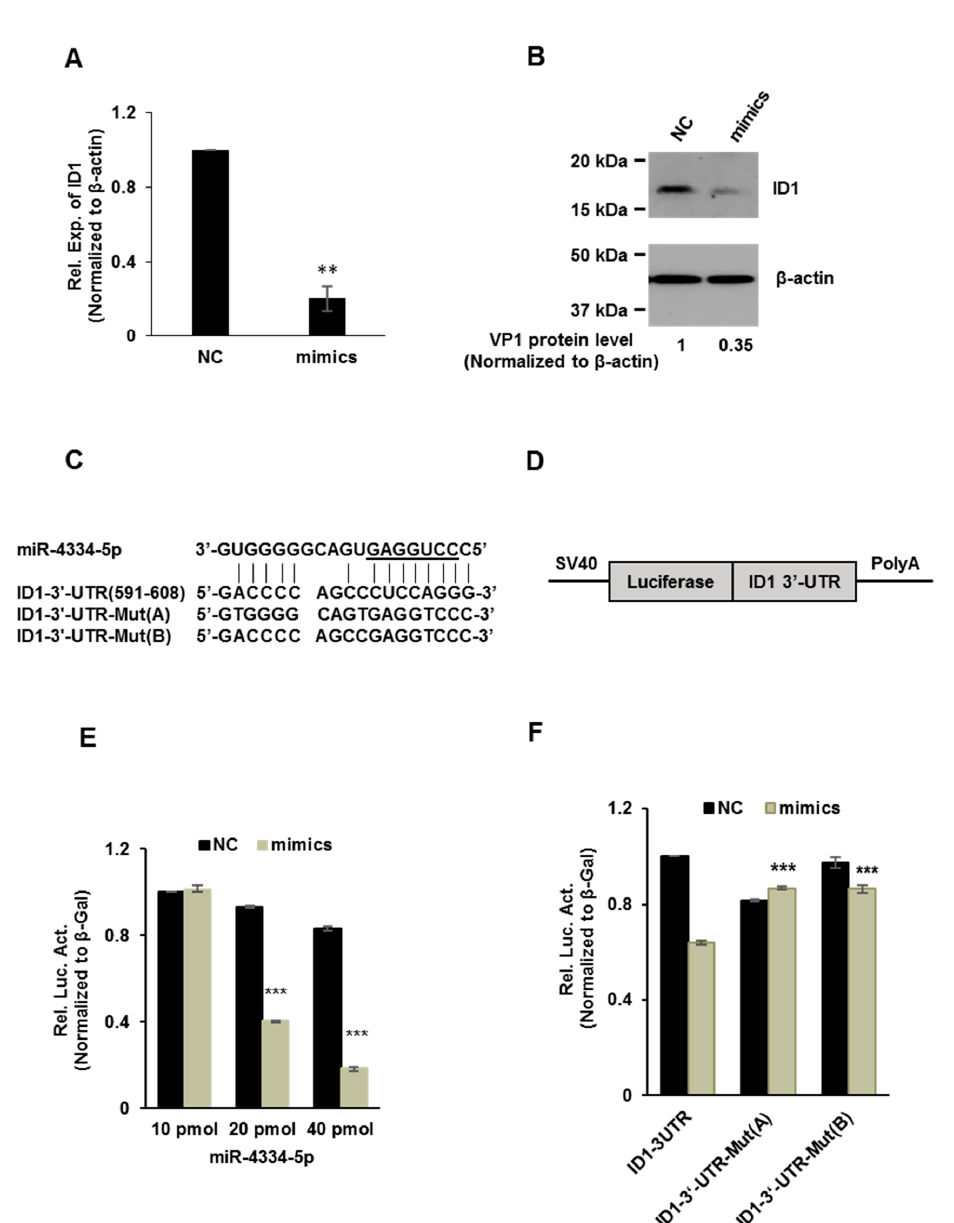
Figure 4. miR-4334-5p directly targets the 3 (cid:48) -UTR of ID1 gene. ( A ). qRT-PCR analysis of the e ff ect of miR-4334-5p on ID1 mRNA expression in PK-15 cells transfected with miR-4334-5p mimics or scramble mimics (NC) at 24 h post transfection, normalized to β -actin. The results shown are means ± SD from triplicate assays, **, p < 0.01. ( B ) Western blot analysis of miR-4334-5p on ID1 expression in PK-15 cells transfected with miR-4334-5p mimics or scramble mimics (NC) at 24 h post transfection, and β -actin was used as a control to indicate the even loading ( C ). Bioinformatic prediction of interaction between miR-4334-5p and the 3 (cid:48) -UTR of swine ID1 using RNA22 and BiBiServ2. For each schematic, the upper sequence is mature miR-4335-5p, the middle sequence is the binding site of miR-4334-5p in 3 (cid:48) -UTR of swine ID1, and the lower sequence is the mutated sequence of 3 (cid:48) -UTR in ID1 gene. The seed sequence is underlined. ( D ). Schematic overview of the putative binding sites or mutation of miR-4334-5p binding-sites in 3 (cid:48) -UTR of ID1 mRNA. ( E ). The ID1 luciferase reporter plasmid was co-transfected with various amount miR-4334-5p mimics or scramble mimics (NC) into BHK-21 cells. Data are represented of relative luciferase activities from triplicate assays, ***, p < 0.001. ( F ) The specific binding activity of miR-4334-5p mimics or scramble mimics (NC). Data are represented of relative luciferase activities from triplicate assays, ***, p <